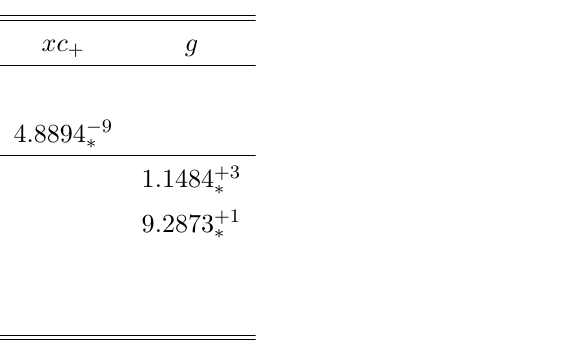
ences can be attributed to the benchmark results, where entries with an asterisk correspond to category 1 and the entry in blue corresponds to